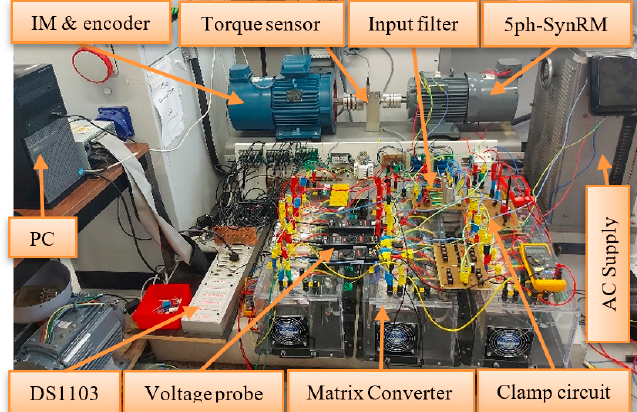
Figure 14. The complete experimental test bench.